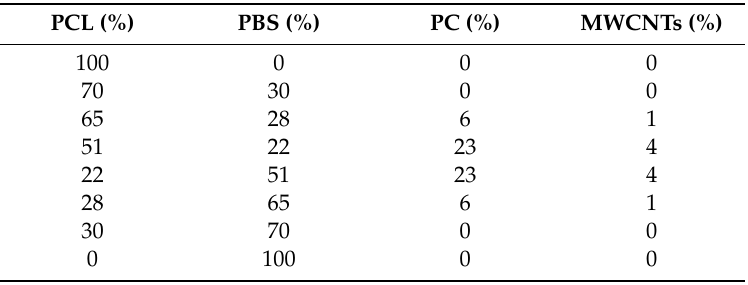
Table 1. Percentages of the components in the